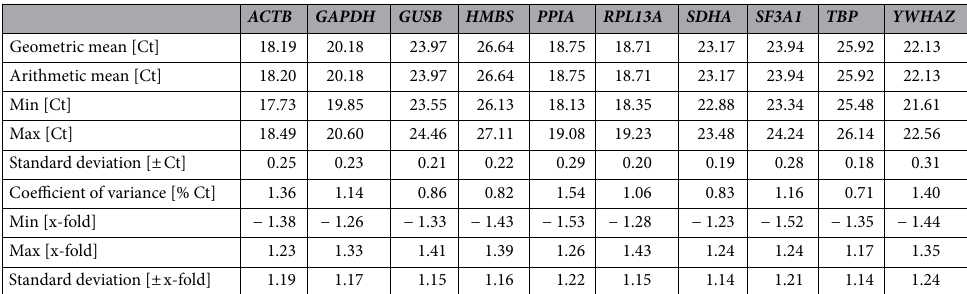
Table 3. BestKeeper candidate RG descriptive statistics, including standard deviation [± Ct], which is used as a cut-off for subsequent BestKeeper Index calculation.